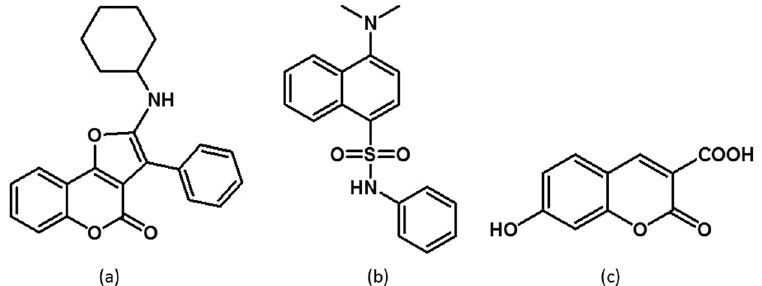
Figure 1. Chemical structures of ( a ) FC, ( b ) DA and ( c ) CC.